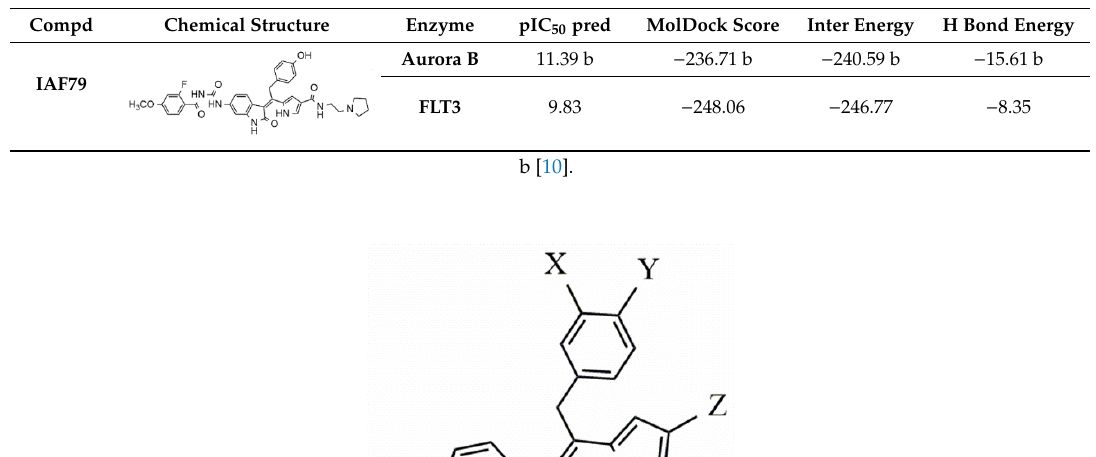
Figure 6. Promising indolin − 2 ‐ one molecular pattern for dual Aurora B/FLT3 activity.